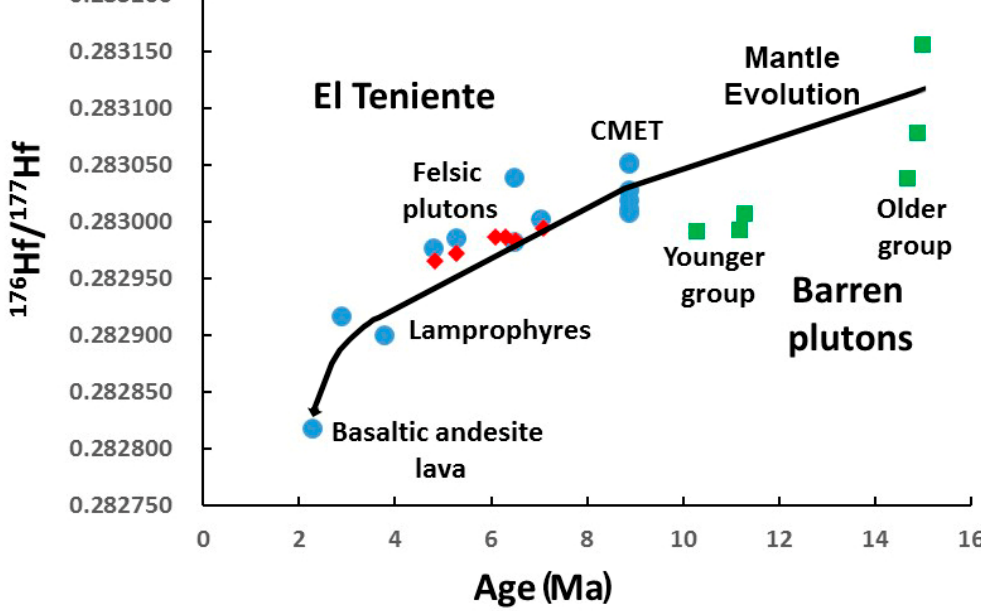
Figure 7. 176 Hf / 177 Hf versus age (Ma) for samples from El Teniente (blue circles from Table 4; red diamonds from [28]) and Middle Miocene barren plutons in the same general area (green squares from [50]). The size of the symbols is greater than the error in the 176 Hf / 177 Hf values. The mantle isotopic evolution line is drawn from the average of the older group of Middle Miocene barren plutons through the Late Miocene Teniente Mafic Complex (CMET) olivine basalts and gabbros, and then to the Pliocene olivine lamprophyres and olivine-bearing basaltic andesites, ignoring the younger group of barren plutons because these have macroscopic evidence for intra-crustal assimilation [50]. The amount of subducted crust plus sediment added to the mantle to generate this line is indicated in Figure 9.